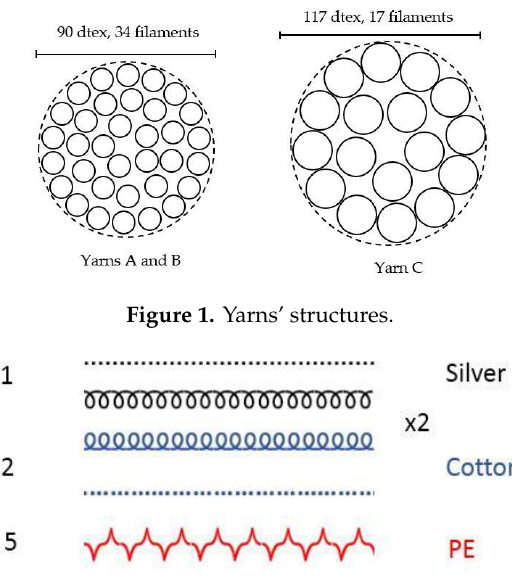
Figure 2. Diagrammatic representation of the fabric.